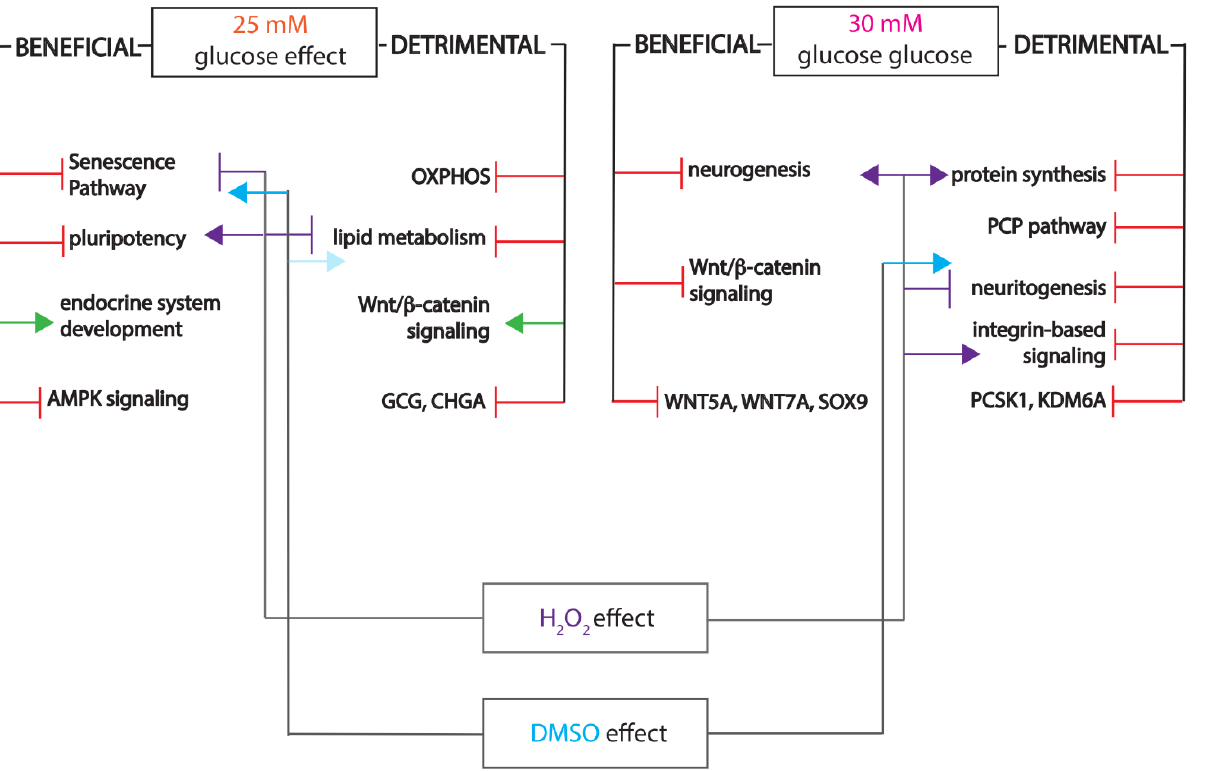
Figure 6. Integrative scheme depicting the beneficial and detrimental effects of elevated glucose levels, including superimposition of the H 2 O 2 and DMSO treatments’ effects.